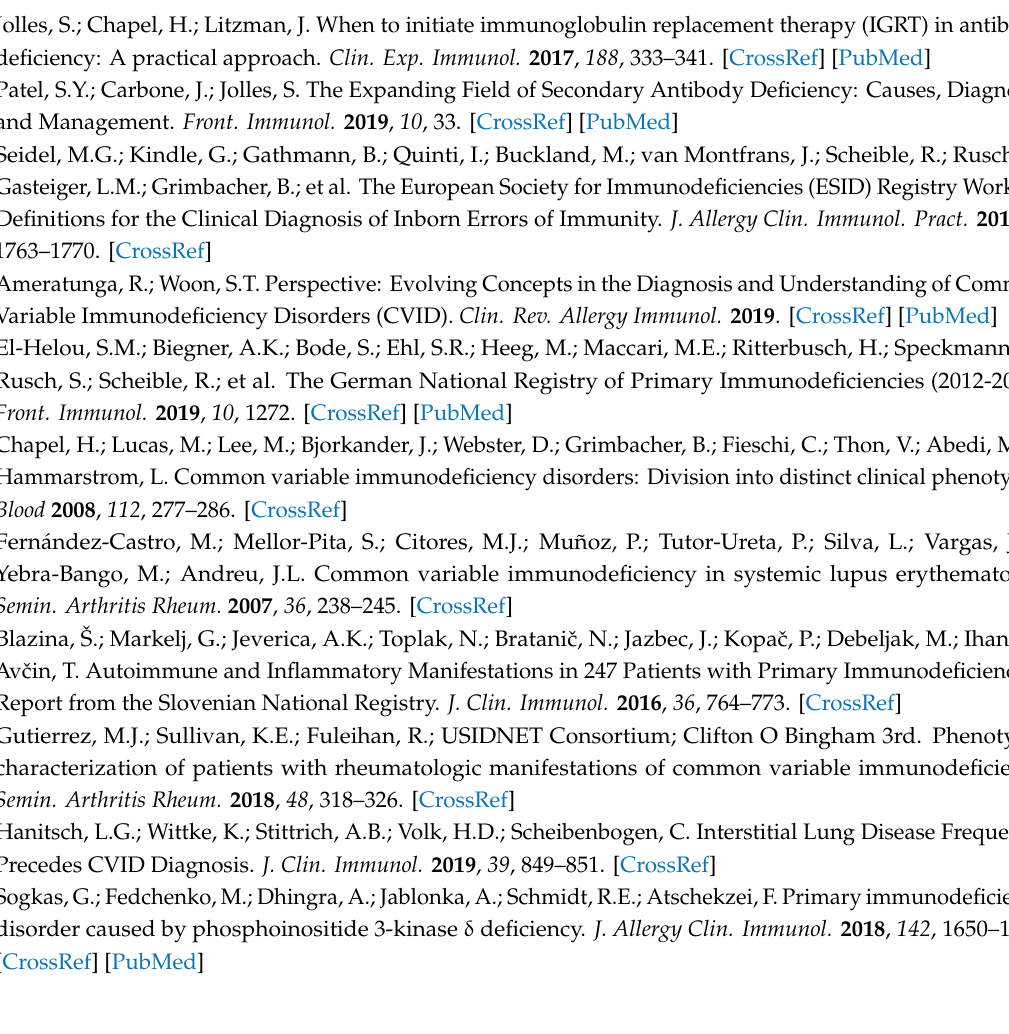
Table S2: lymphocyte subset counts of patients with PID on anti-inflammatory